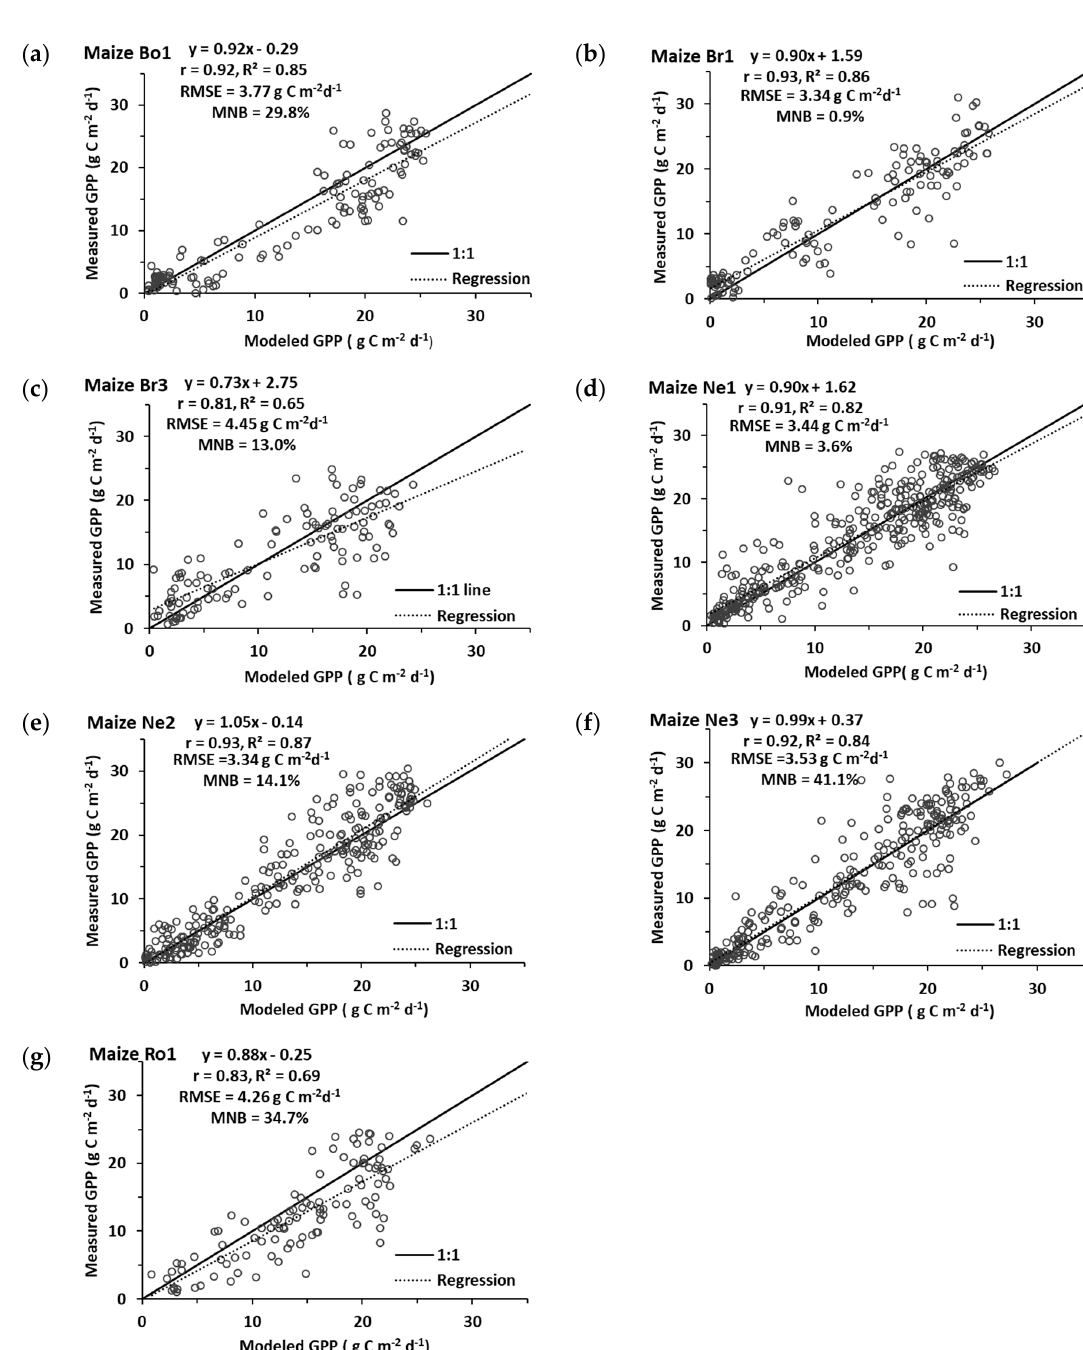
Figure 5. Measured AmeriFlux vs. LUEc modeled daily GPP for all maize validation years by site: ( a ) US-Bo1; ( b) US-Br1; ( c ) US-Br3; ( d ) UN-Ne1; ( e ) US-Ne2; ( f ) US-Ne3; and ( g ) US-Ro1.